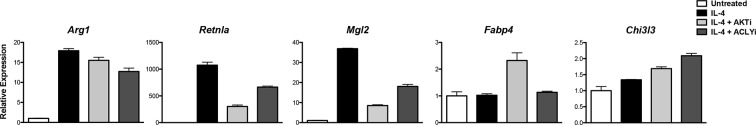
Akt-Acly signaling regulates M2 activation in peritoneal macrophages. Elicited peritoneal macrophages were treated for 16 hr with IL-4 +/- the indicated inhibitors, followed by analysis of M2 gene induction by qRT-PCR.